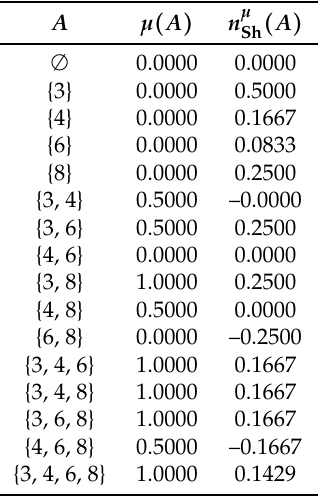
Table 6. The capacity on {3,4,6,8} and its Shapley nonadditivity